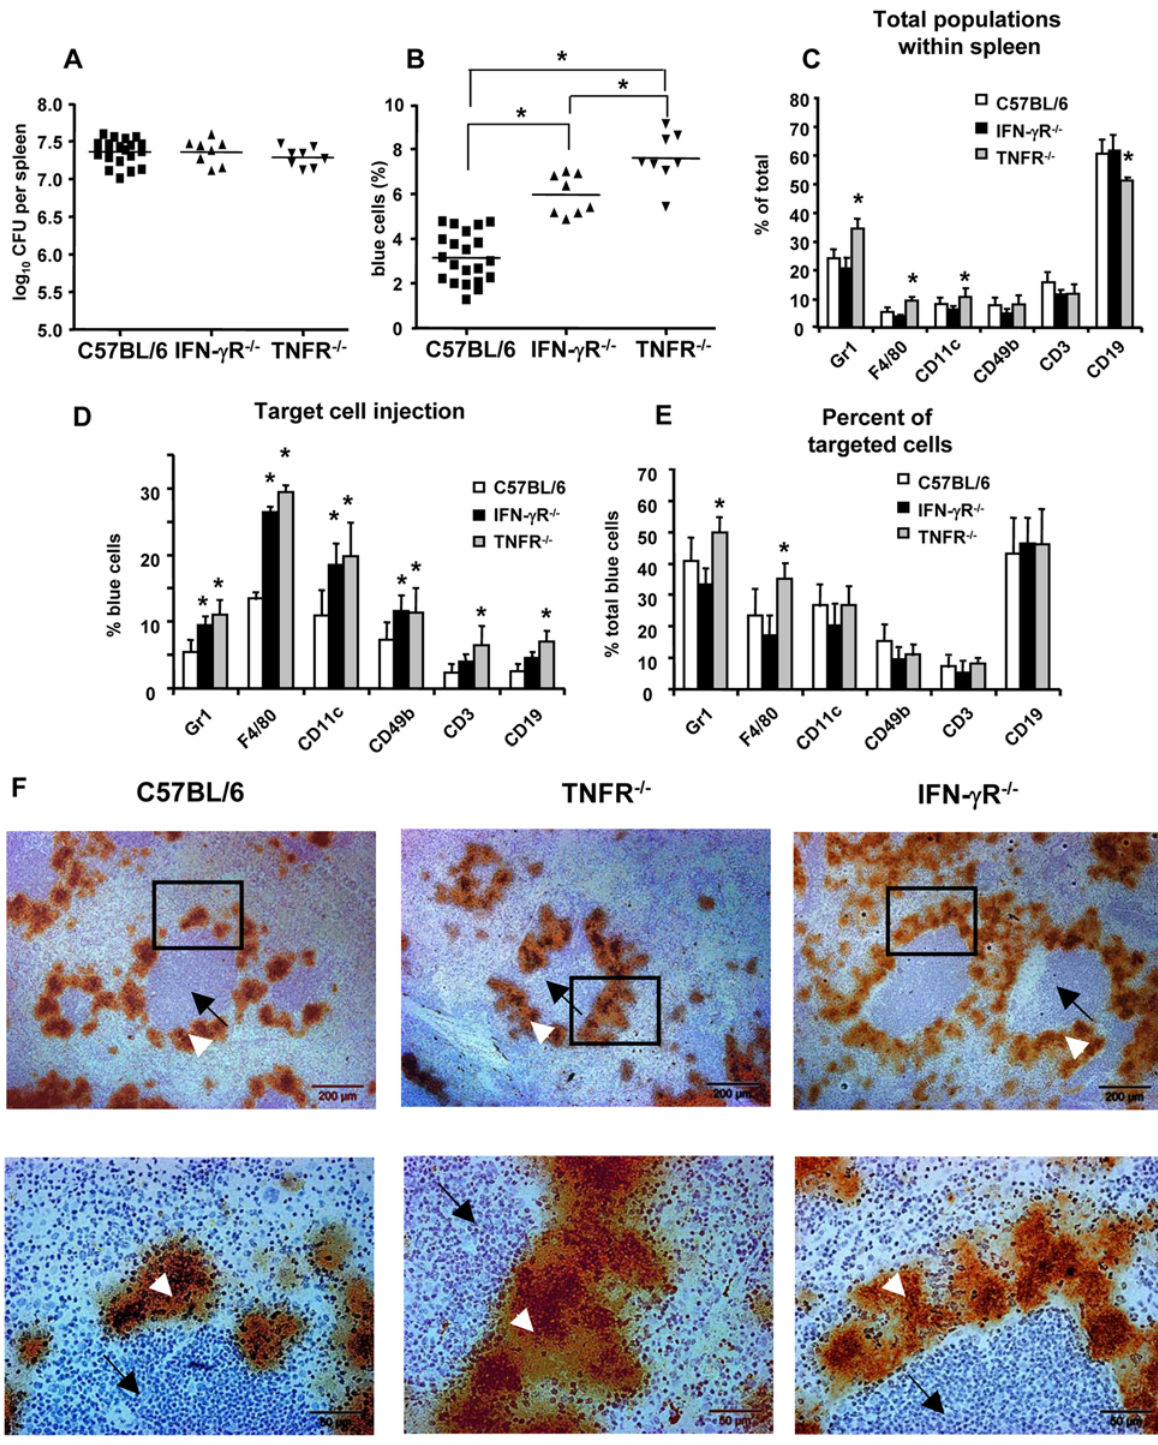
Figure 8. Impact of IFN- c R and TNF-R deficiency on Yop injection. IFN- c R 2 / 2 , TNFRp55 2 / 2 and control C57BL/6 mice were infected with E40- pBla and two days later (A) bacterial load in the spleen and (B) percentage of blue cells was determined. Each dot depicts the results for one single mouse (in total 8–22 mice were investigated). Data in (C) show the mean and SD of the distribution of cell subpopulations expressing indicated markers, in (D) the mean and SD of percentage of blue cells of each indicated subpopulation and in (E) the mean and SD of the percentage of the indicated subpopulations of blue cells. Asterisks show significant differences between all groups compared (A, B, one-way ANOVA with Bonferroni corrections, p , 0.05) and differences between control mice and knockout mice (C, D, E; one-way ANOVA, with Dunnett corrections, p , 0.05). F. Immunohistology of infected spleen of indicated mice. Splenic sections were stained with anti-hsp60 and counterstained with Mayer’s hemalaun. White arrowheads mark lymph follicle and black arrows colonies of yersiniae. All the experiments were repeated more than four times using in total 8–22 mice. Marked regions are shown at higher magnification in lower panels.